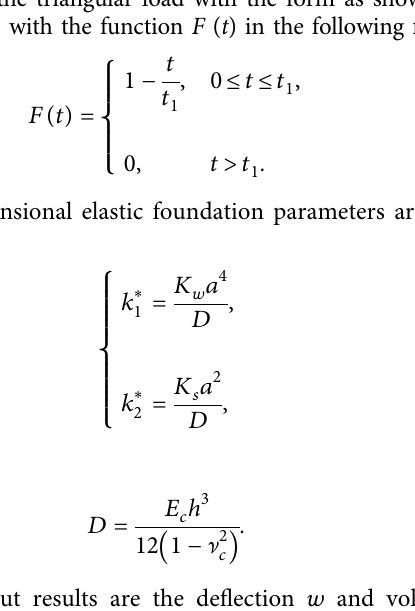
Figure 11: The dependence of w c on the temperature with two FG